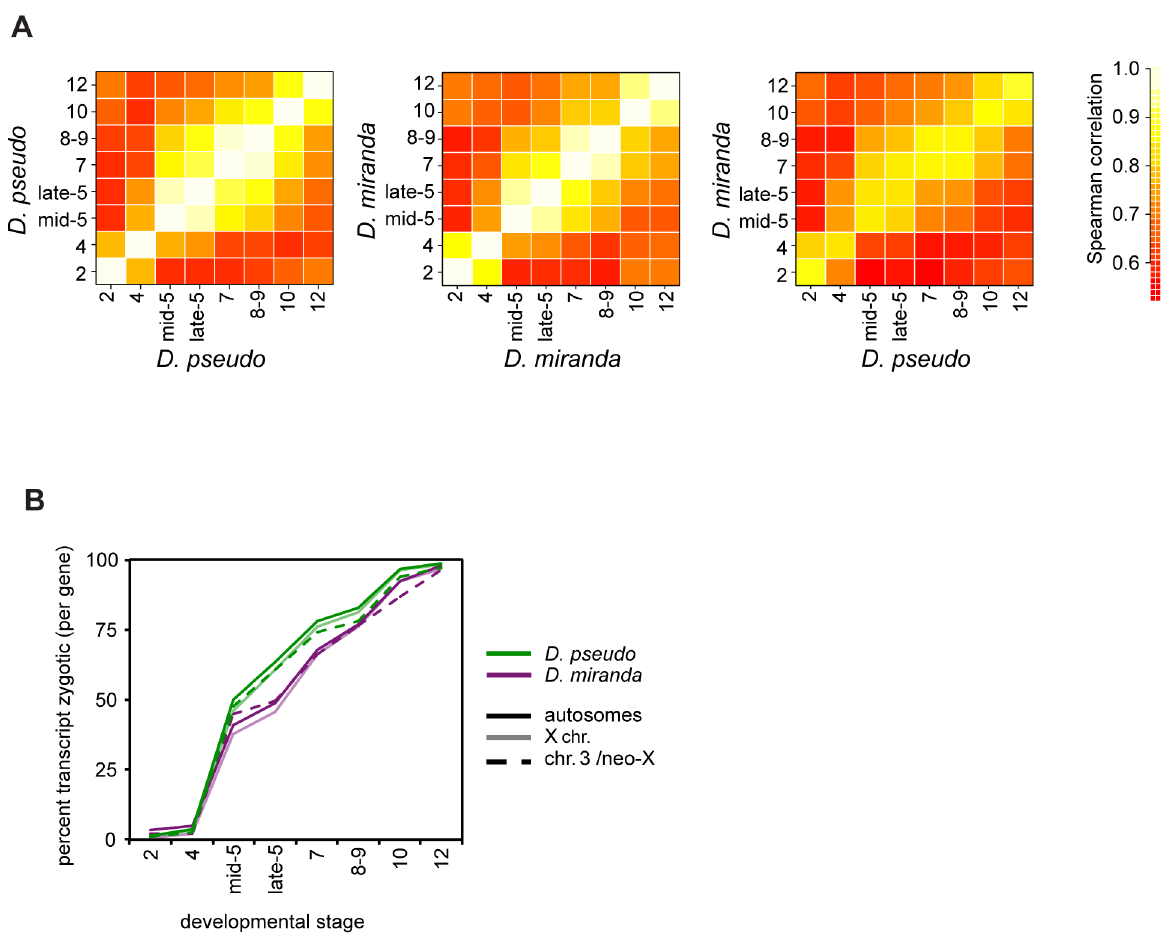
Figure 2. Timing of transcript abundances in D.pseudoobscura and D.miranda . A) A heatmap of pairwise correlation coefficients for mRNA abundance for genes (in RPKM) at all stages, averaged over all individuals per stage. The first two plots show within species comparisons, the third shows the between species comparison. D. pseudoobscura and D. miranda have very similar expression patterns at each stage, over this period of development. See Table S2 for numerical values. B) Percent of reads per gene that are zygotic in origin, estimated from the proportion of paternal reads (x2) over developmental time, for both species. These plots are derived from female embryos, as males have no paternal allele for X-linked genes. Solid lines are autosomes, pale lines are X chromosomes, and dotted lines the neo-XY/Chr.3. See Table S3 for significance tests of between- species differences.